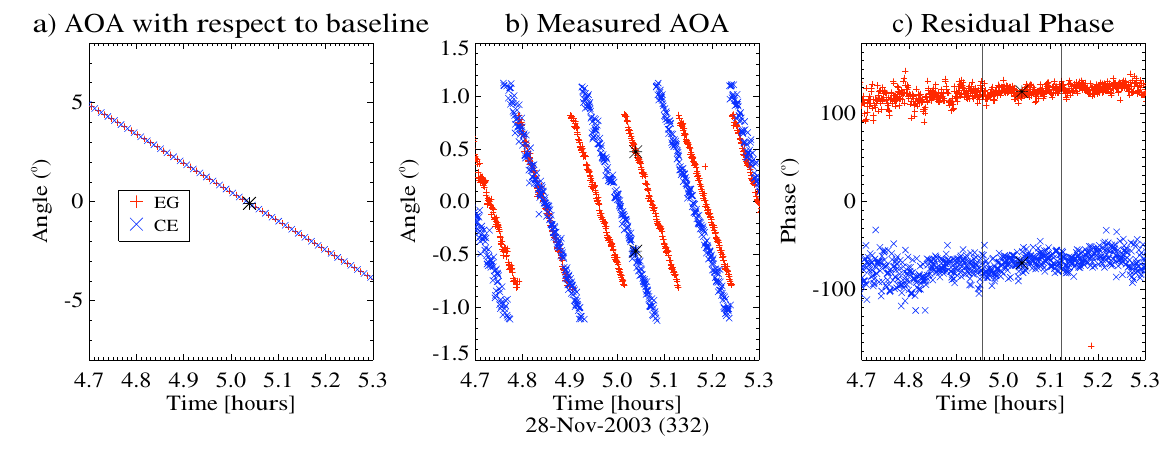
Fig. 2. Fringe stopping. (a) Expected Hydra angle of arrival (AOA) with respect to a baseline; (b) Measured AOA (note phase wrapping due to 2 π ambiguity), and (c) Residual phase after removing the expected Hydra information. The star symbol in panel (b) indicates the transit time over Jicamarca. The vertical lines in panel (c) indicate the time interval for getting an average value ( ± 5min around Hydra’s transit time). Red ( + ) and blue ( × ) indicate values for a selected pair of antennas, i.e. EG and